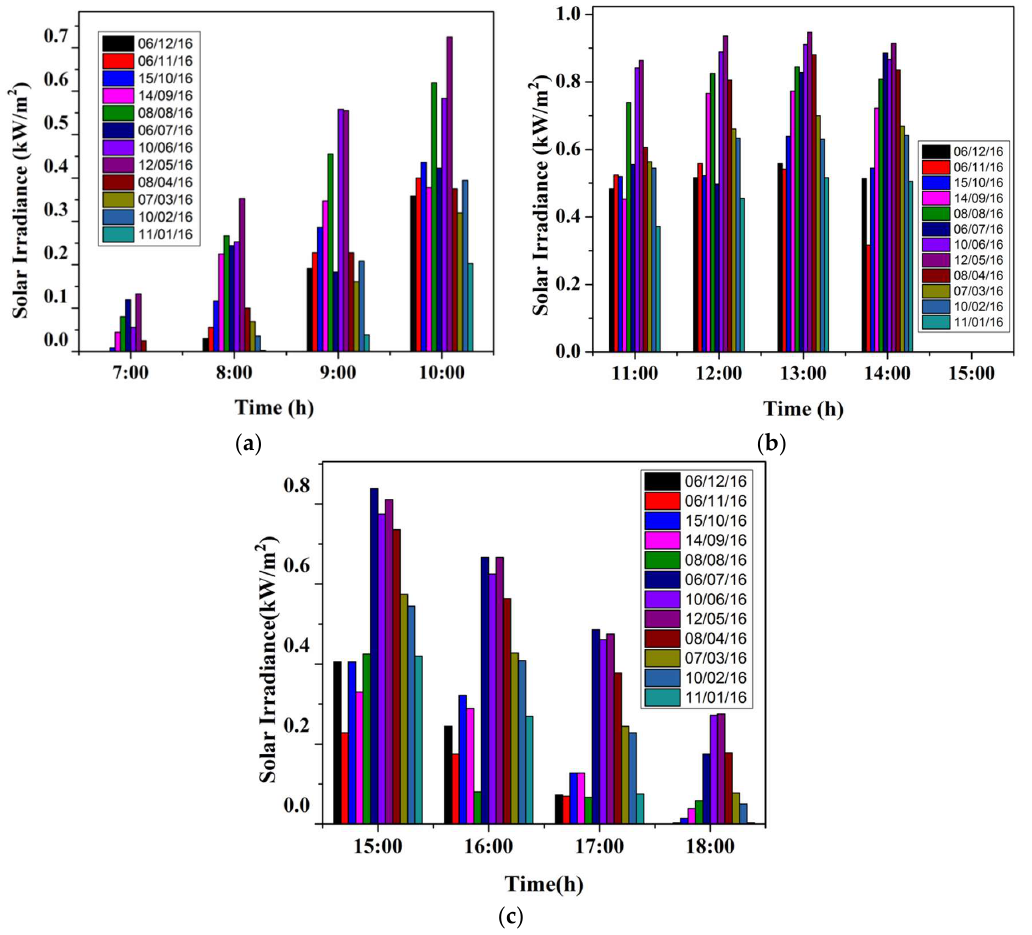
Figure 11. Solar irradiance of Busan (35°10′0″ N, 129°4′0″ E): ( a ) Morning (7:00 to 10:00); ( b